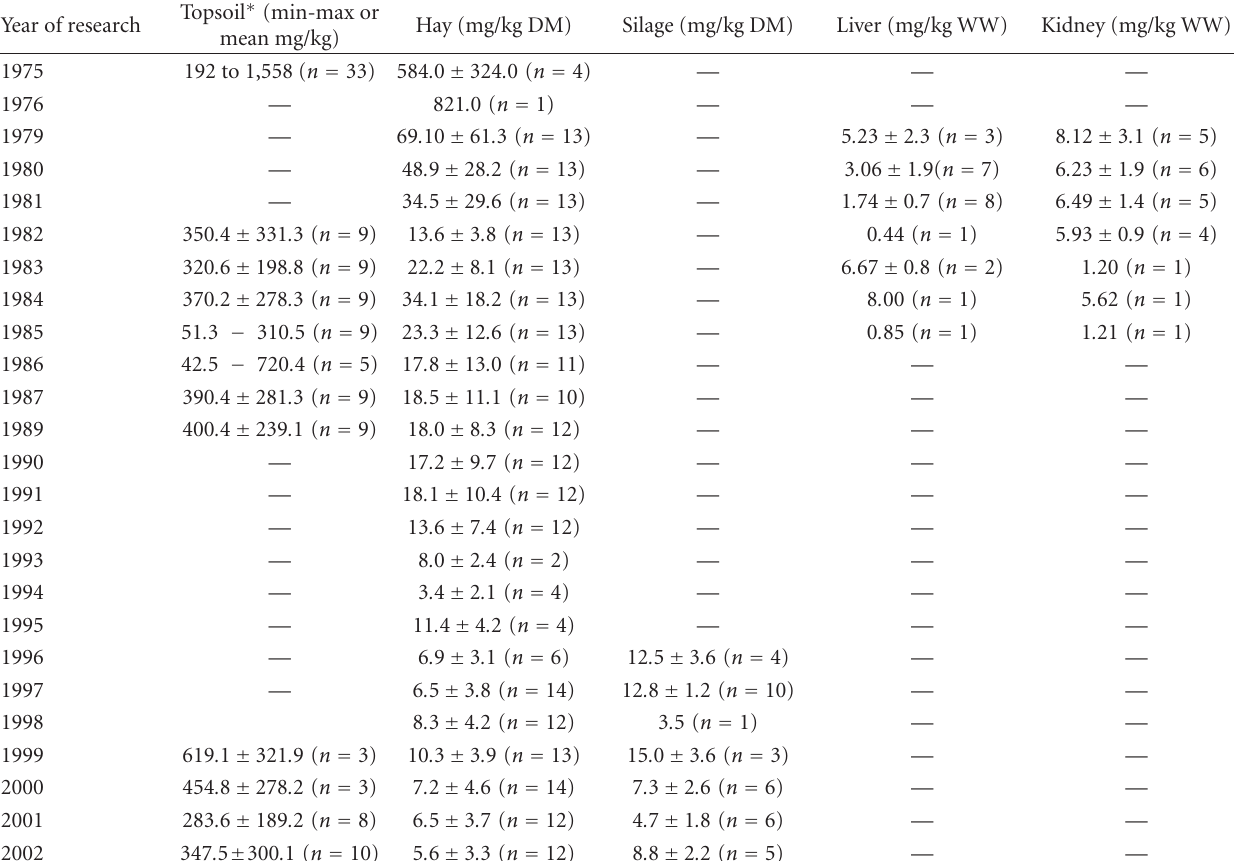
Table 3: Mean lead concentrations in topsoil, hay, silage, liver, and kidney of cows from farms near the lead mine and smelter before the installation of bag filter system in 1975/1976 and after the installation from 1979 to 2002. Year of research